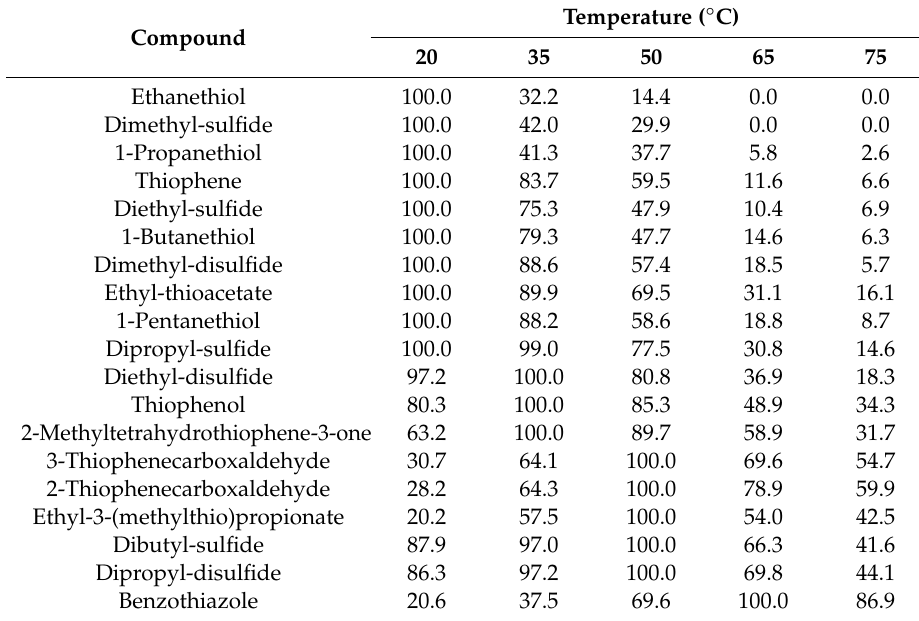
Table 2. The e ff ect of extraction temperature on the response of individual tested compounds. Data expressed as percent of maximum value obtained for each